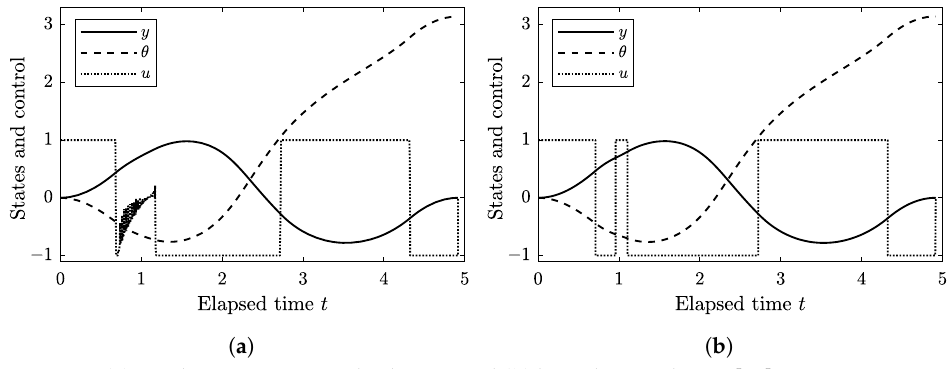
Figure 2. ( a ) Single-stage numerical solution, and ( b ) bang-bang solution [21].